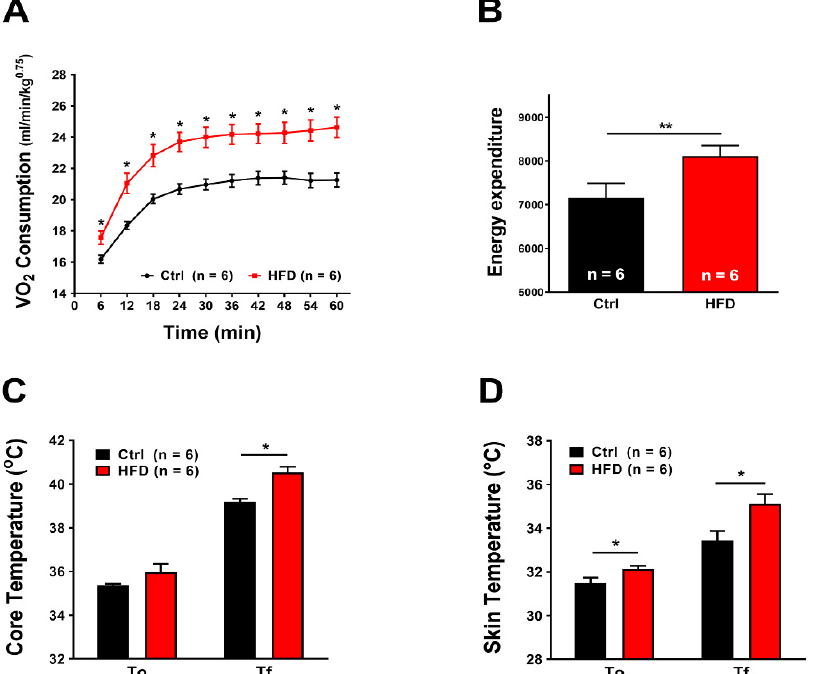
Figure 5. VO 2 consumption, energy expenditure, and temperature recorded during heat stress protocol (41 ◦ C for 1 h). ( A ) Oxygen consumption expressed as mL/min/kg 0.75 . ( B ) Area under the curve of 60 min energy expenditure. ( C , D ) Core and skin temperature, immediately before (T 0 ) and at the end (T f ) the heat stress protocol. Data are shown as mean ± SEM (* p < 0.05 and ** p < 0.01), as evaluated by two-way ANOVA followed by Tukey’s post-hoc test (panel A ) or two-tailed unpaired Student’s t -test (panels ( B – D )). n = number of mice tested.